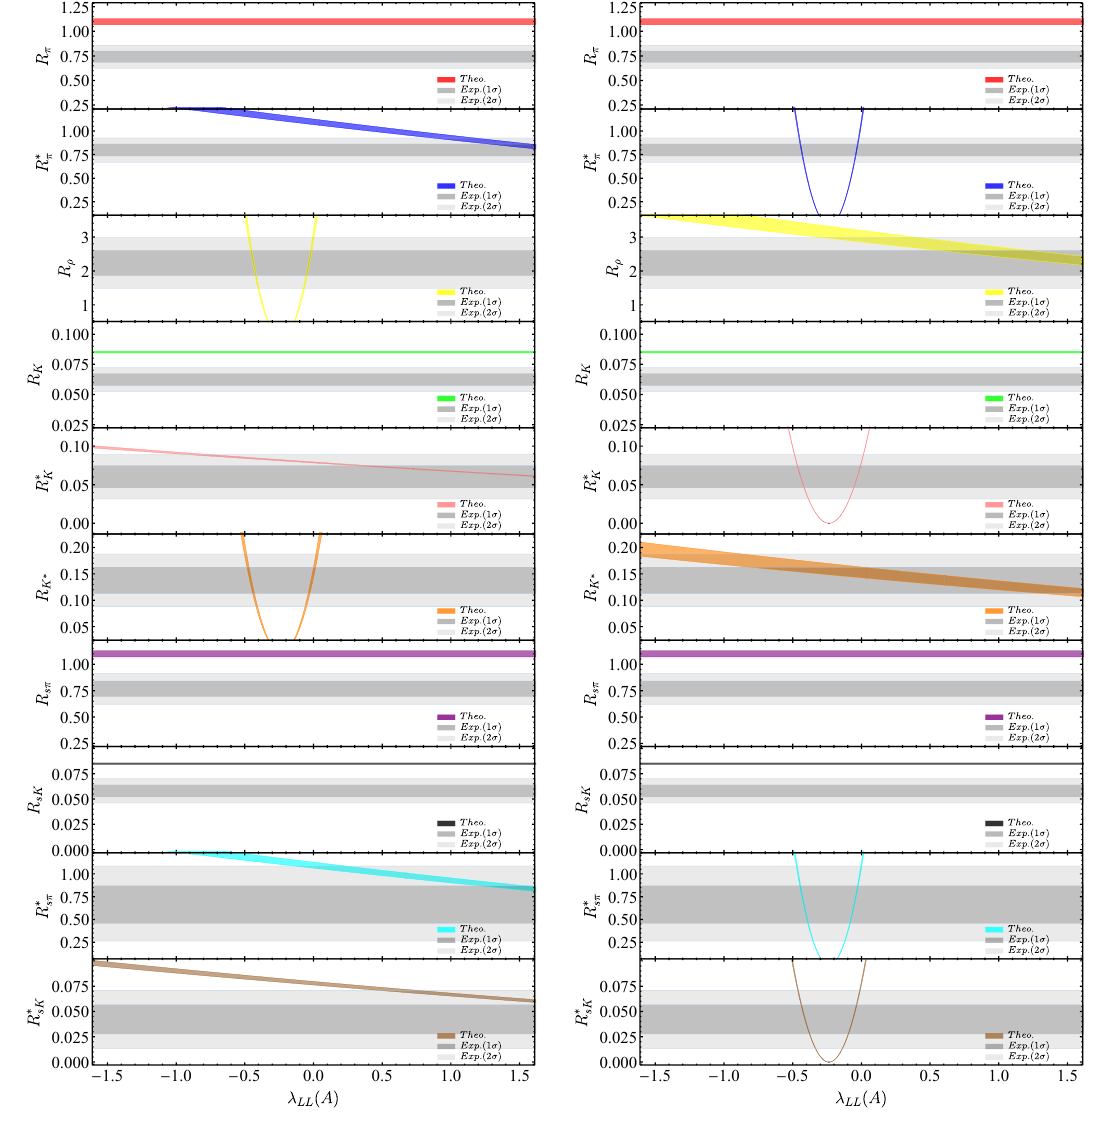
collected in table 6, ( s ) L